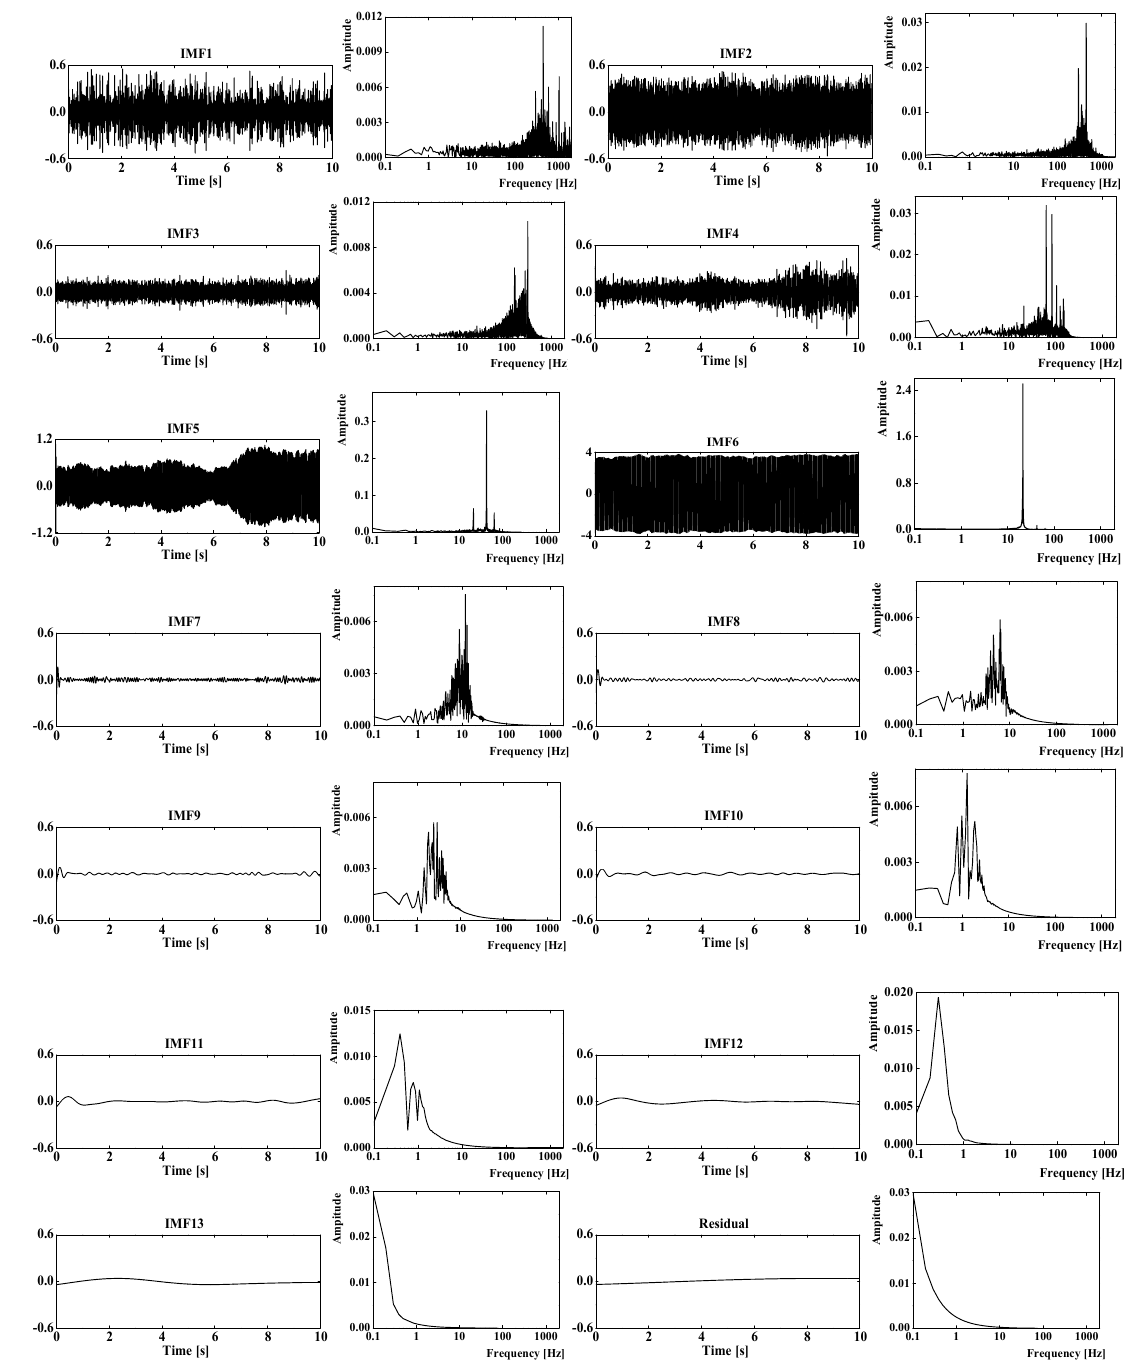
Figure 11. Intrinsic Modal Function (IMF) components and their Fourier spectrum s.